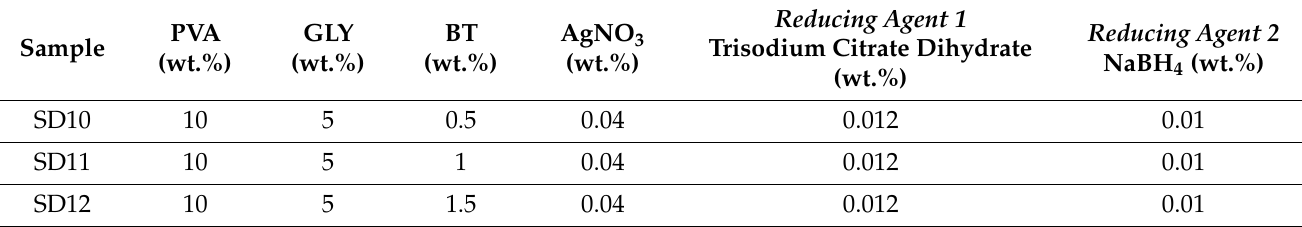
Table 3. Composition of the solutions containing